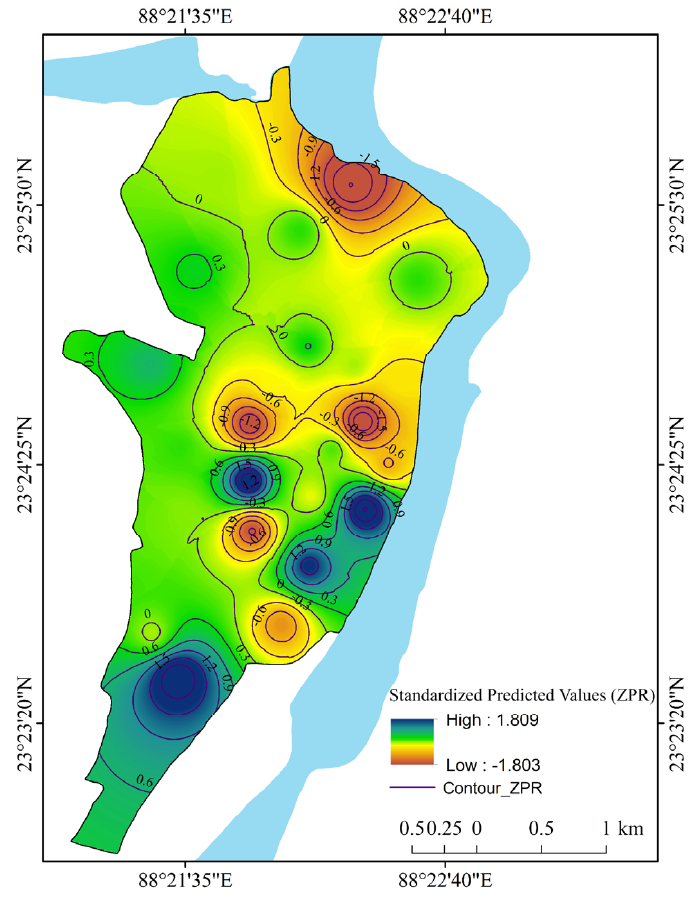
Figure 50. Plots of regression ZPR (2015).